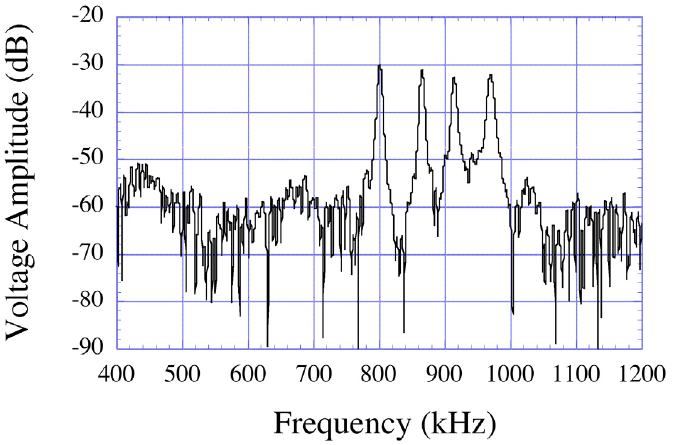
Figure 14. Simultaneous measurement of a four-element magnetoelastic sensor array, such as that shown in Figure 10, after a FFT conversion of captured time-domain response. Reprinted with permission from